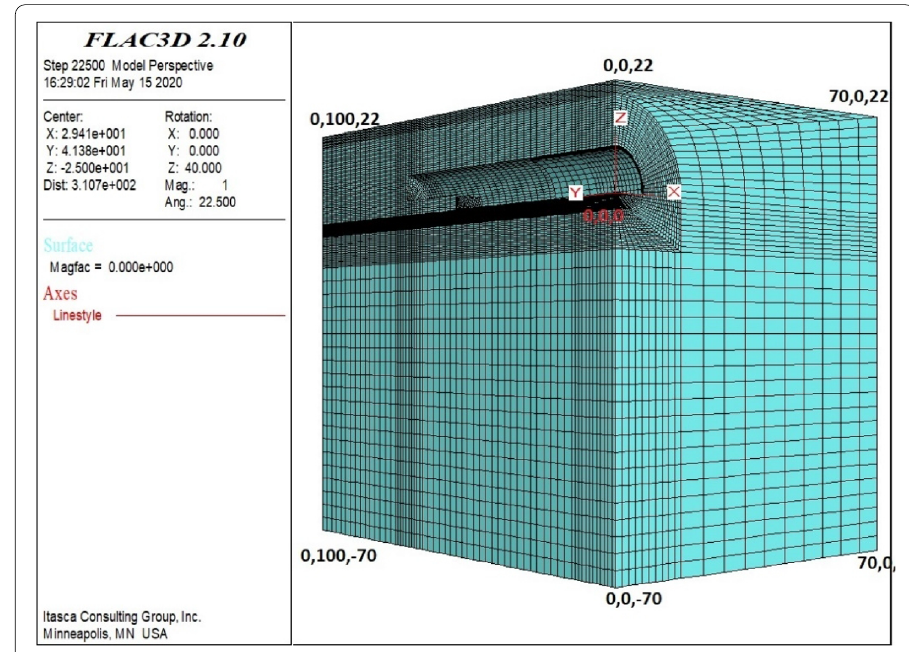
Fig. 13 FLAC3D model of the tunnel between the inlet portal and km: 210